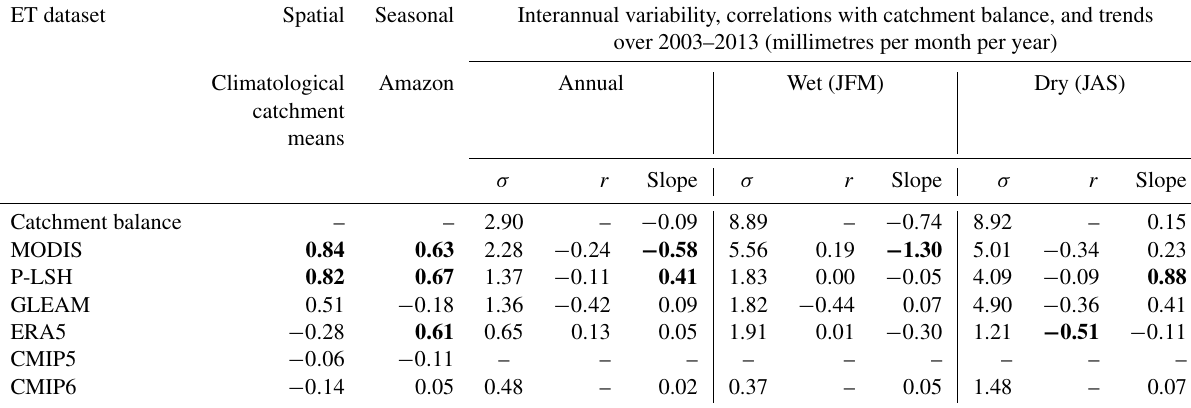
Table 2. Summary of comparative statistics. Datasets listed in the table were correlated with catchment-balance evapotranspiration (ET) estimates (spatial, seasonal, and interannual), and interannual standard deviations ( σ ) were calculated over the 2003–2013 period using data standardised by the climatological mean over that period (in units of millimetres per month per year). Interannual analysis was performed using data from all months (annual), January to March (JFM), and July to September (JAS). Statistically significant ( p < 0 . 05) relationships are shown in bold. Note that CMIP data were not correlated at the interannual scale because model years would not be expected to align with real-world years. ET dataset Spatial Seasonal Interannual variability, correlations with catchment balance, and trends over 2003–2013 (millimetres per month per year) Climatological Amazon Annual Wet (JFM) Dry